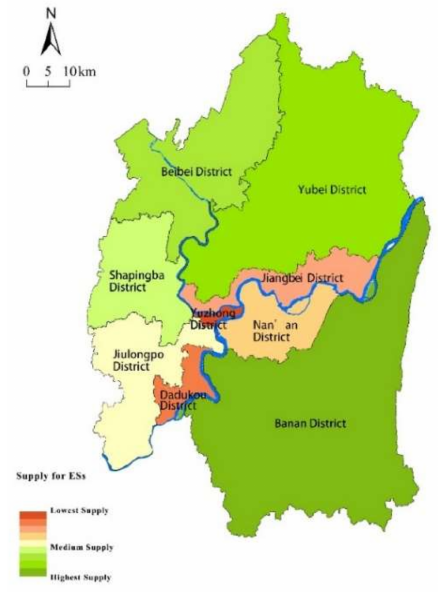
Figure 5. Spatial distribution of ESs